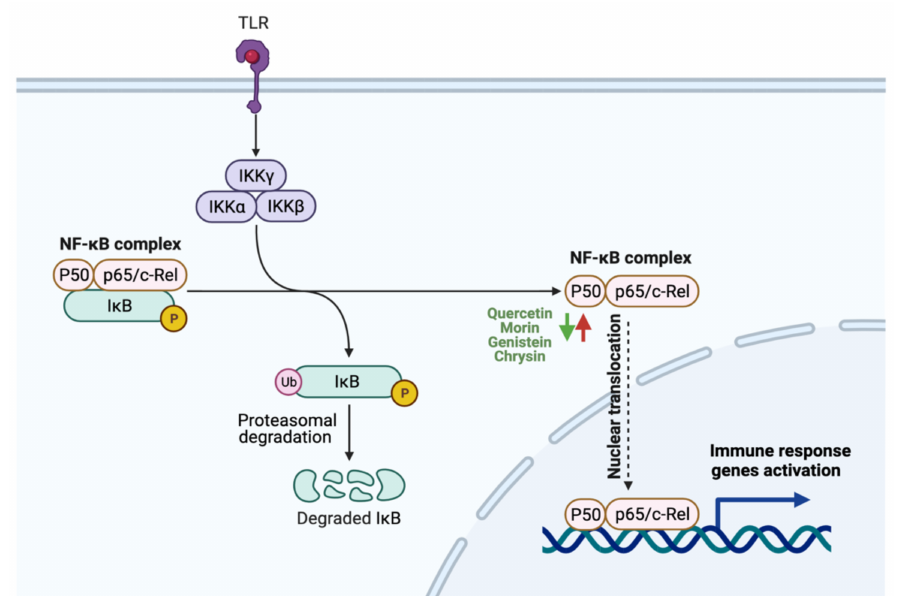
Figure 5. Schematic illustration of the impact of flavonoids on inflammation. The figure illustrates NF- κ B complex activation. Red arrows represent the effects of GI cancer on the pathway, while the green arrows for flavonoids effect. Adapted from “NF- κ B signaling pathway”, by BioRender.com (accessed on 3 August